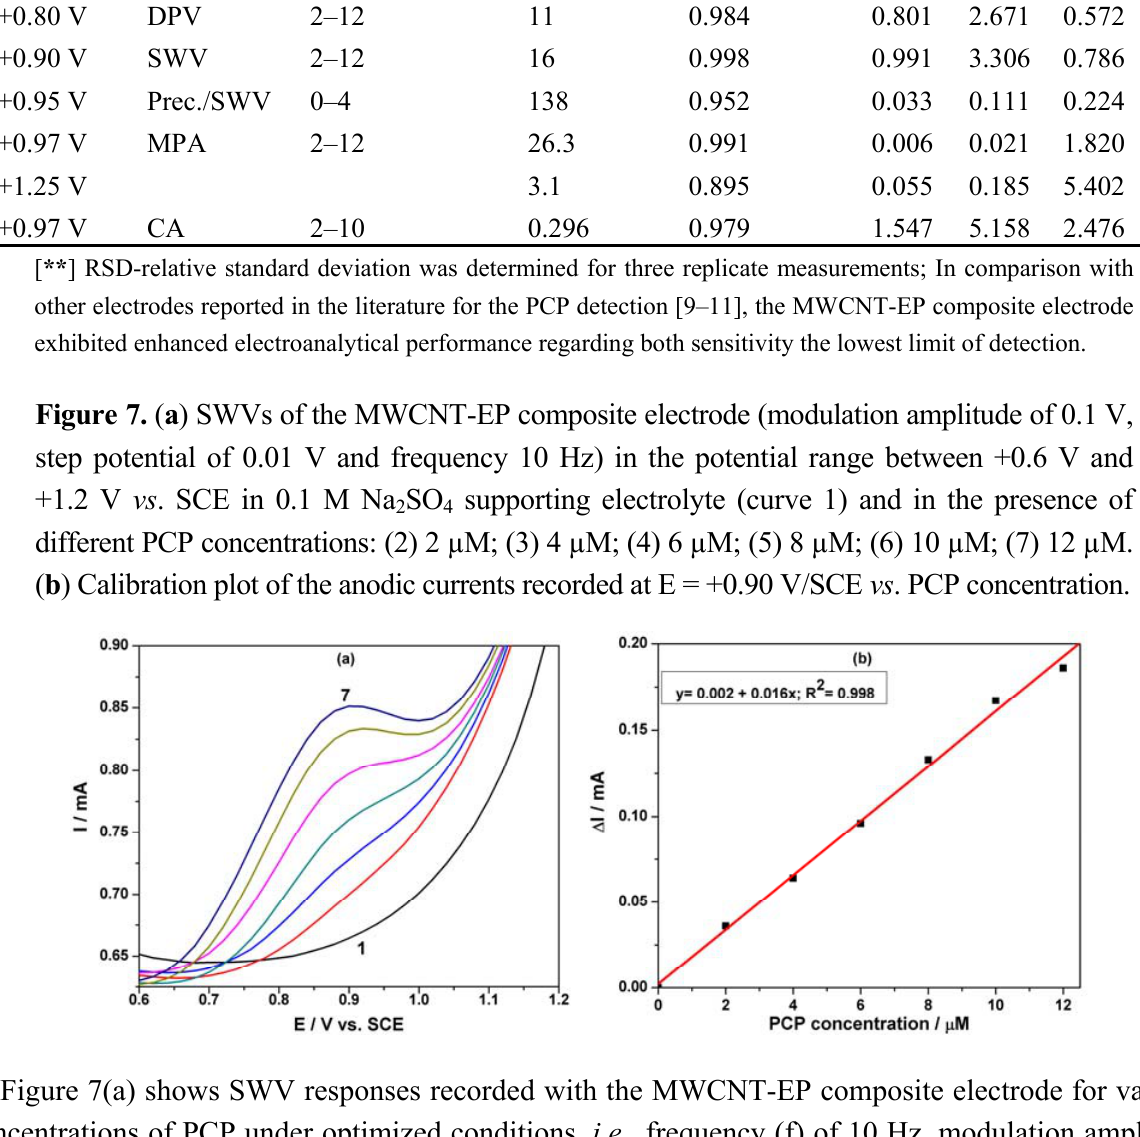
Table 1. Electroanalytical performance of the MWCNT- EP composite electrode for the detection of PCP in 0.1 M Na